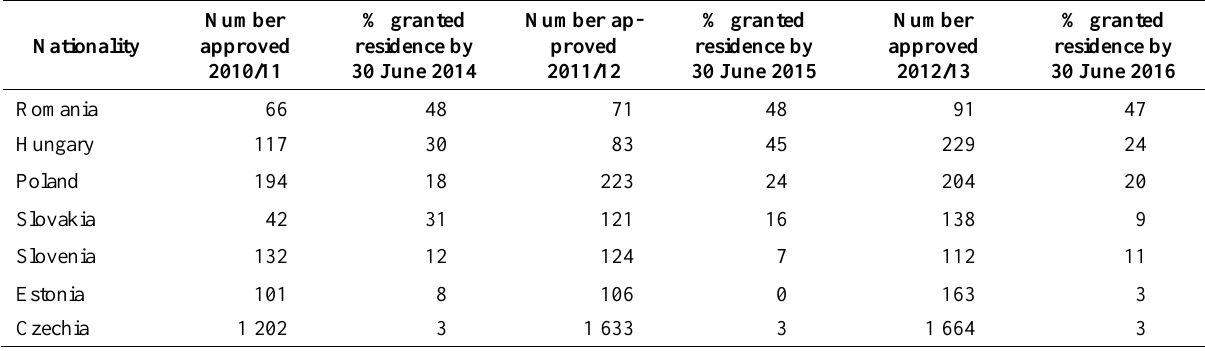
Table 5. Proportion of first-time temporary workers gaining residence within three years, top 7 CEE